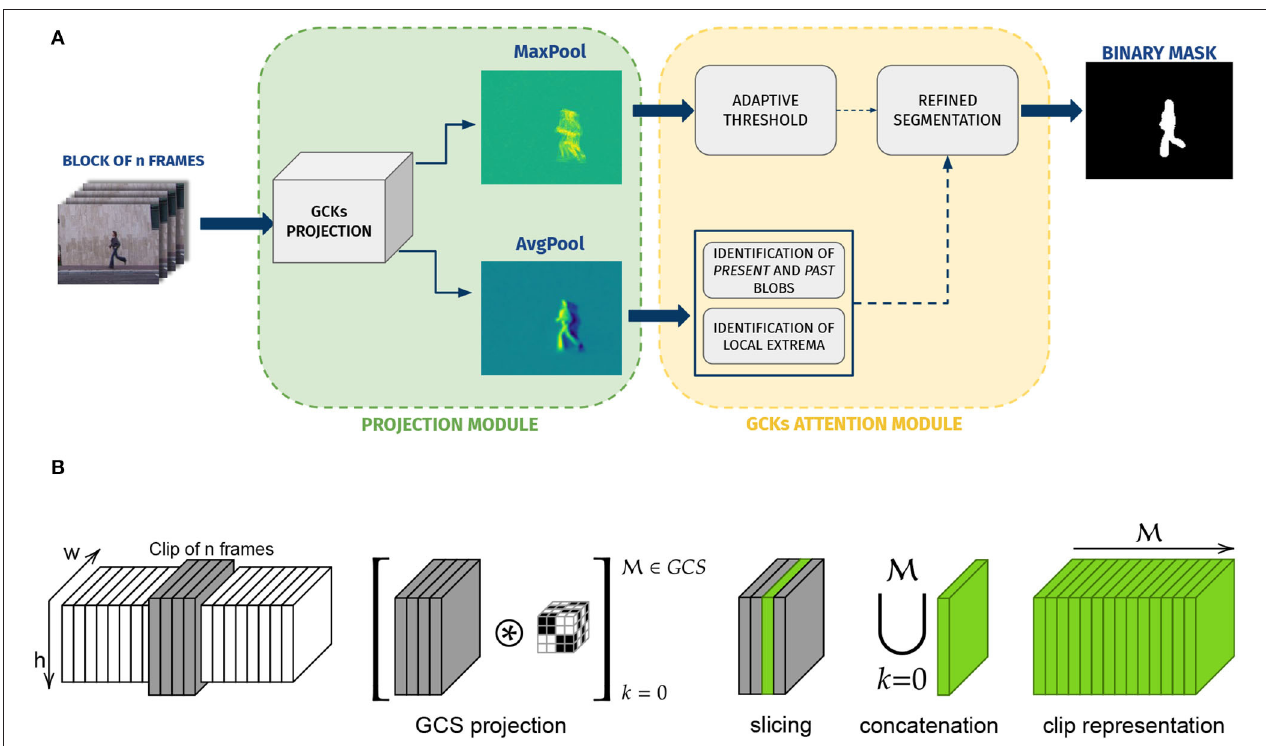
FIGURE 6 | Visual description of our entire pipeline for unsupervised motion saliency segmentation. (A) A visual representation of the processing flow of our method. (B) Inside the Projection module: our procedure takes in input a clip of n video frames, computes the GCKs projections, and composes the